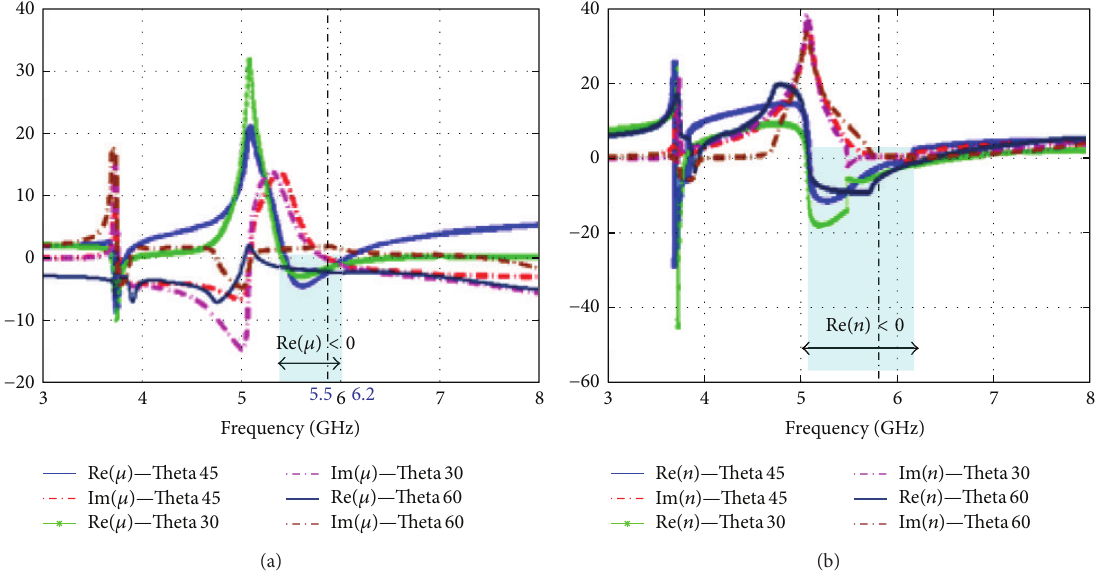
Figure 12: Effective permeability (a) and refraction index (b) values are obtained with varying incident wave.